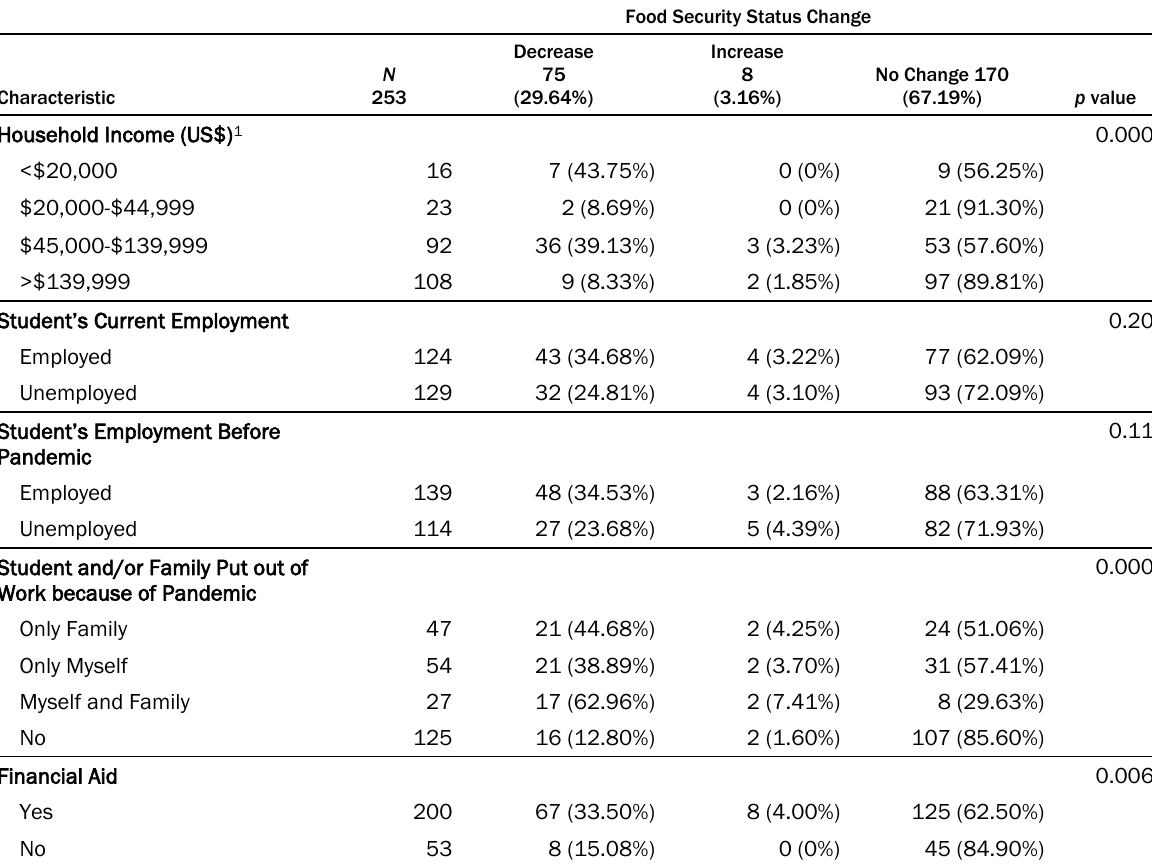
Table 2. Results of Fisher Exact Test for Food Security Status Change and Financial